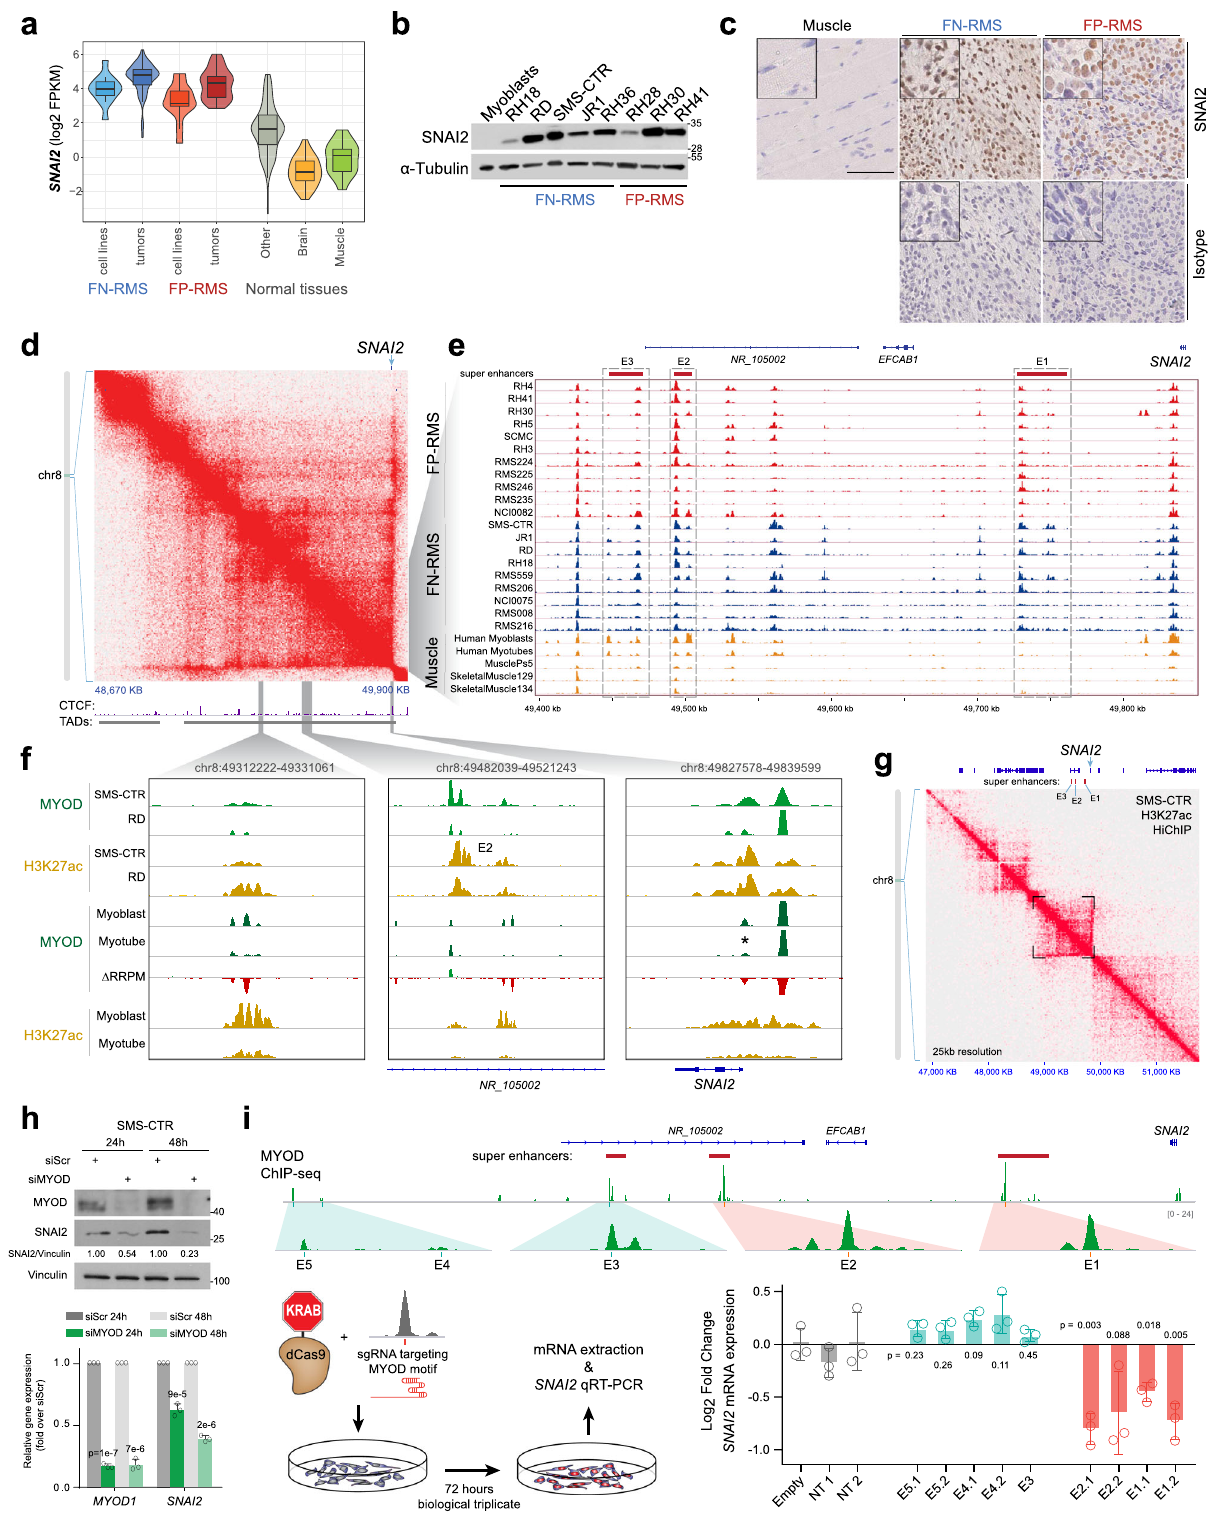
While FP-RMS and FN-RMS had similar enhancer structure surrounding SNAI2 and transcriptomic levels of SNAI2 , there is a selective dependency for SNAI2 among FN-RMS cells when compared to a panel of cancer cell lines in genome-wide CRISPR screening data from the Achilles Project (Fig. S1g, h).Together our data provide evidence that SNAI2 is expressed in RMS, is regulated by a 1.2 Mb regulatory locus to which muscle-speci fi c